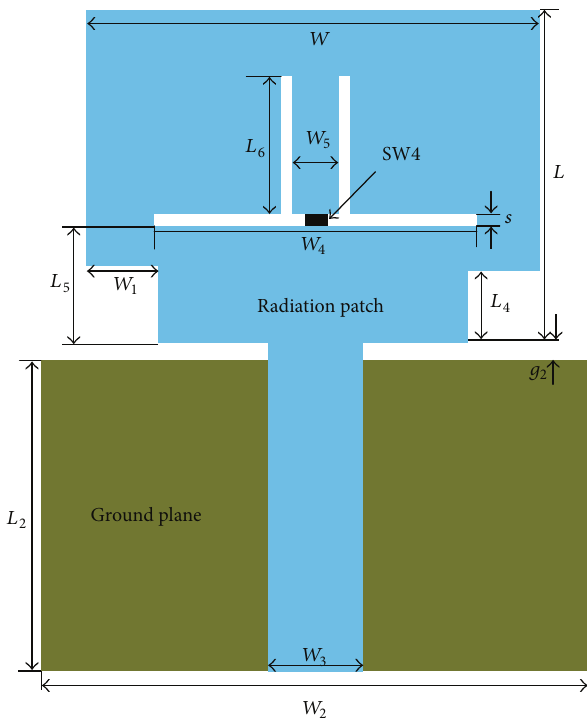
3.1 GHz to 14 GHz. CRA A with DMS-BSF has two stop bands near 5.5 GHz and 11.5 GHz, respectively. The two notched bands are generated by DMS-BSF which changes the distributive inductance and capacitance of the microtrip feed line. This also alters the current path on the microtrip Figure 7: Structure of proposed CRA B. feed line. For comparison, the tuning band-notched charac- teristics of CRA A with all switches OFF are analyzed and shown in Figure 5. We can see that both of the notched The dimensions of DMS-BSF of CRA A are 𝐿 1 = 6.6 mm, bands move to lower frequencies by increasing 𝐿 1 . The gap = 𝑔 = 0.5 mm, and 𝑔 1 = 0.4 mm. lower notched band near 5 GHz shifts slowly, while the higher notched band near 10.5 GHz shifts faster. In addition, the CRA A works as a tunable band-notched antenna by altering the parameters of DMS-BSF. It is also a UWB antenna with two stop bands which can reduce or avoid EMI between broadband wireless systems and narrow